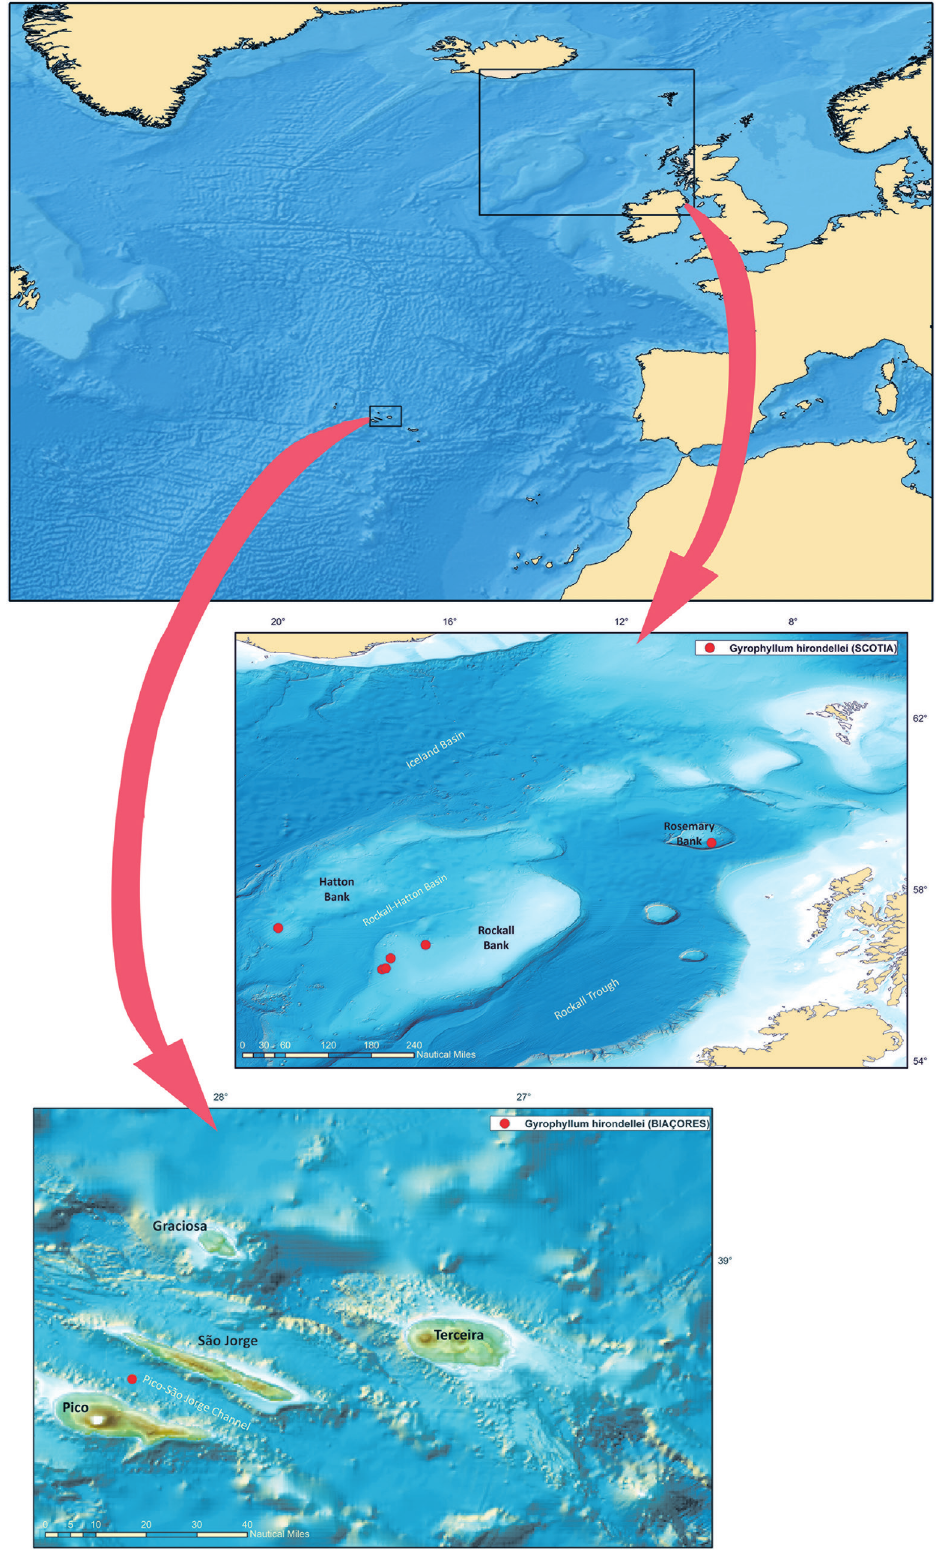
Fig. 1. Distribution of the sampling stations for Gyrophyllum hirondellei Studer, 1891 material examined over the course of this